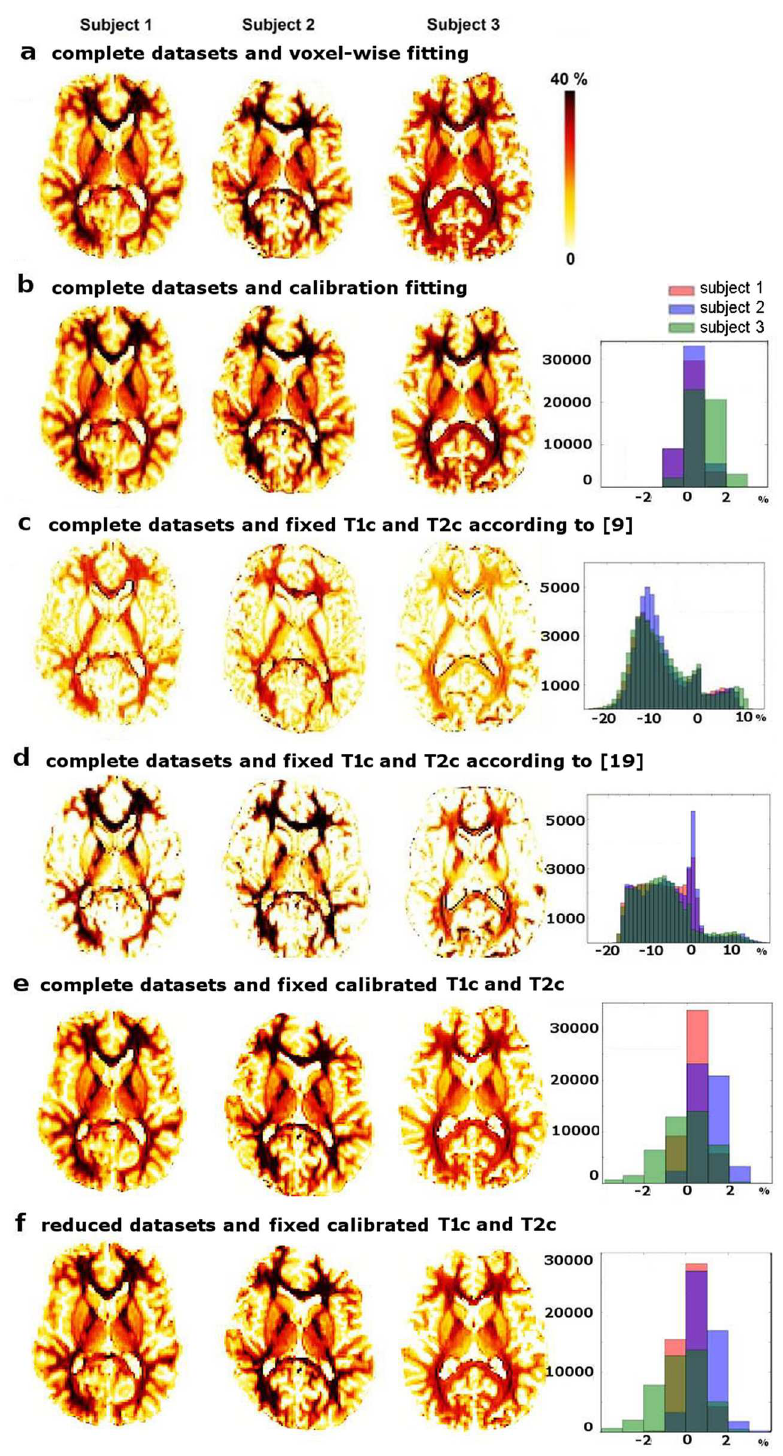
Fig 2. f my maps in the 3 calibration adult subjects. For each subject, f my maps were computed according to different strategies based on either the complete datasets (a-e) or datasets with reduced numbers of measurements (f). Maps were first estimated without fixing T 1 c and T 2 c , using voxel-wisefitting (a) or slice- wise fitting (b: maps computed at the calibrationstage). Second, T 1 c and T 2 c were fixed accordingto the literature (from [9] and [19] in c and d respectively), or to calibratedvalues (e, f). Maps are